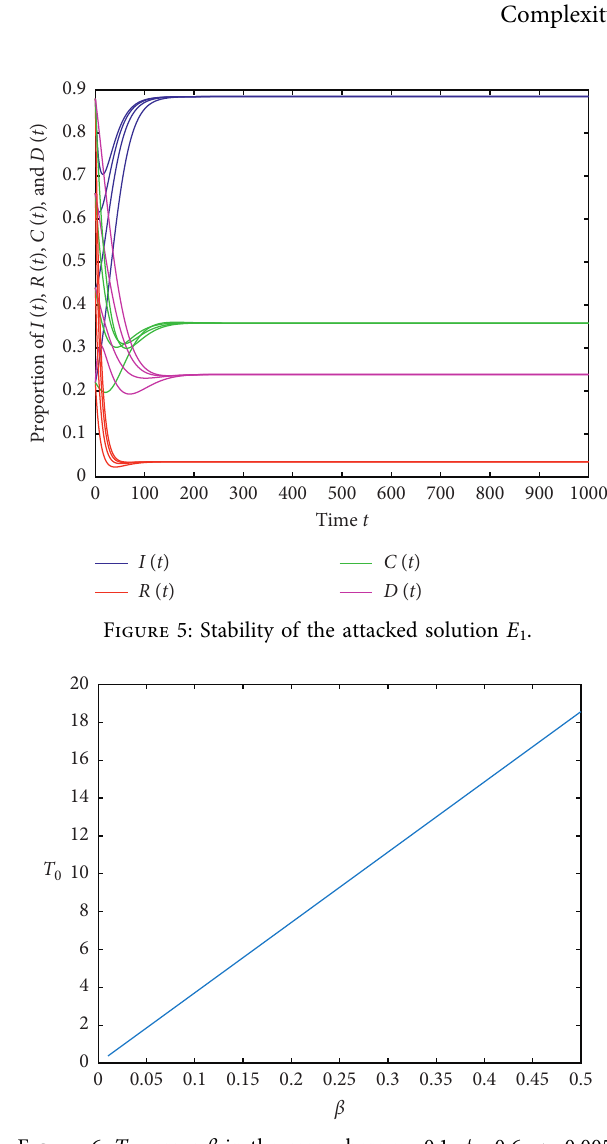
c � 0.1, ϕ � 0.6, τ � 0.005,